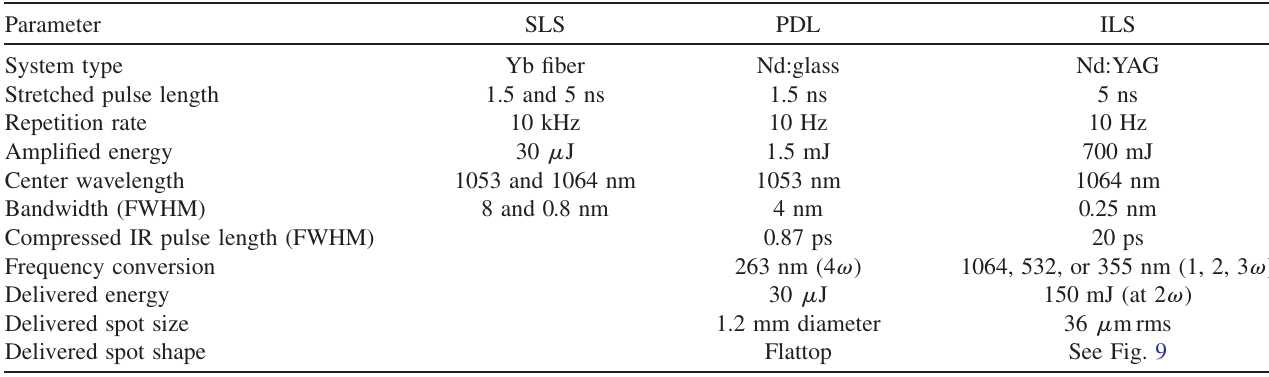
TABLE I. Summary of SLS, PDL, and ILS parameters after amplification and compression. Parameter